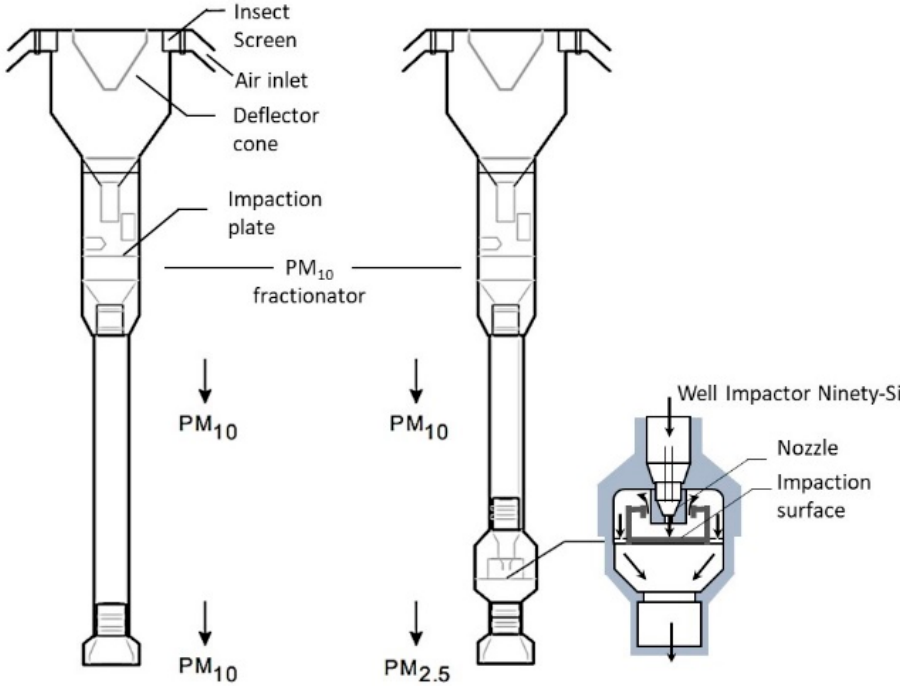
Figure 2. Schematic of a standard low-vol PM10 inlets aspirating at 16.7 lpm (actual conditions). On the right the schematic of a sampling head equipped with PM2.5 aerosol fractionation using a well impactor ninety-six (WINS).